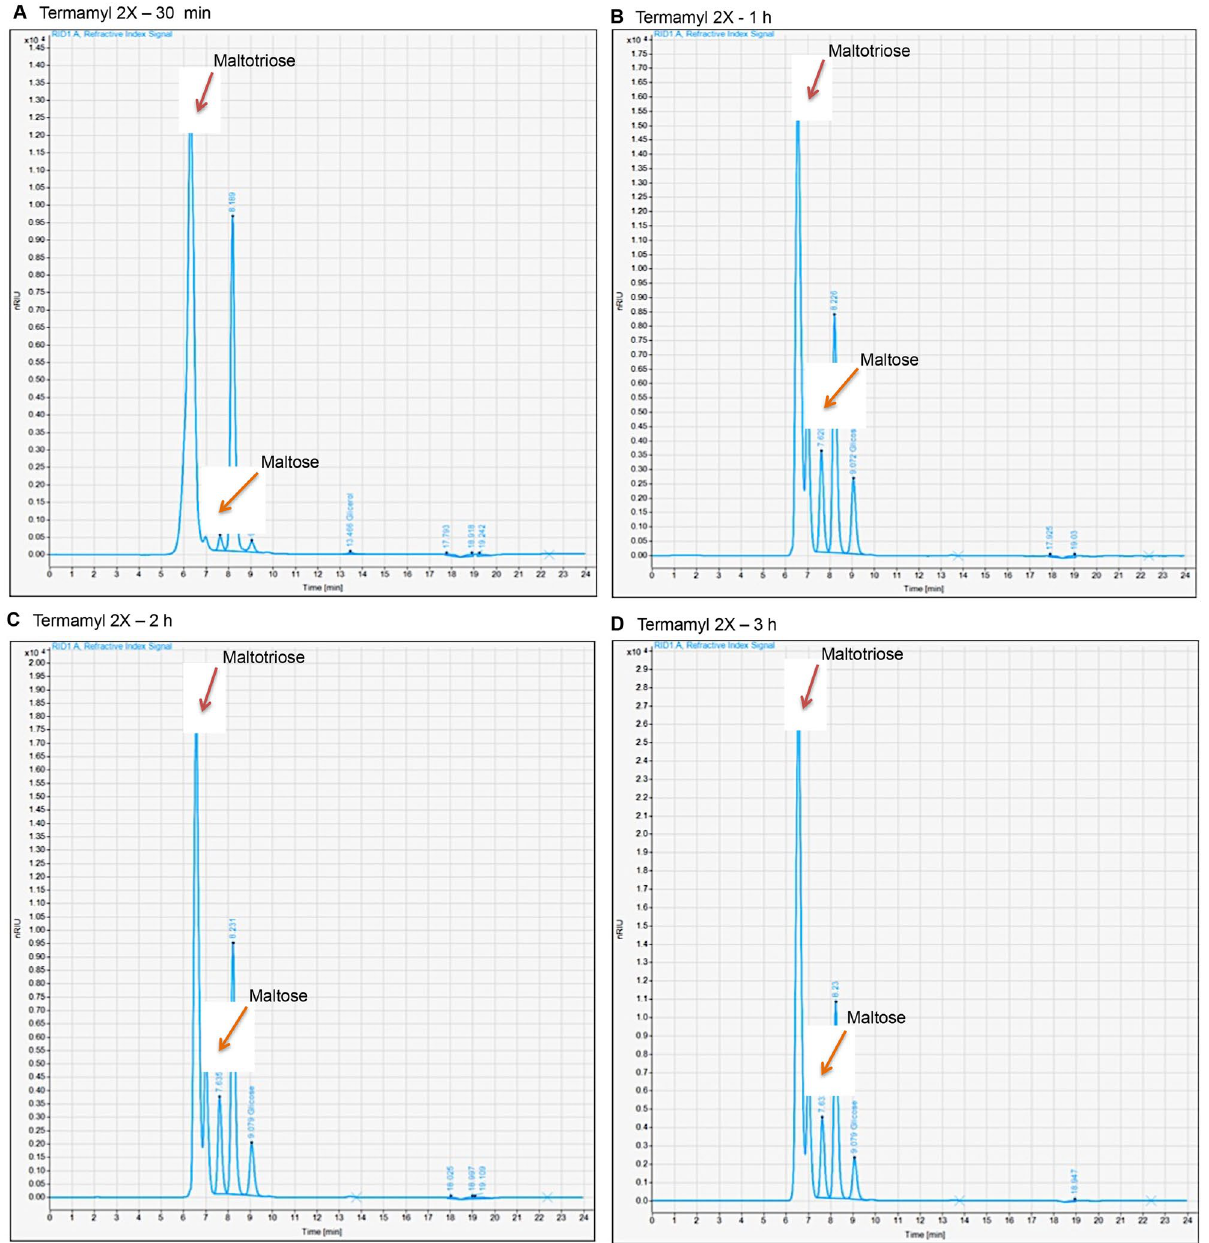
Figure 2. Chromatograms of the samples of the hydrolysis reactions with: (A) 30 min of action of Termamyl 2X; (B) 1 h of action of Termamyl 2X; (C) 2 h of action of Termamyl 2X and (D) 3 h of action of Termamyl